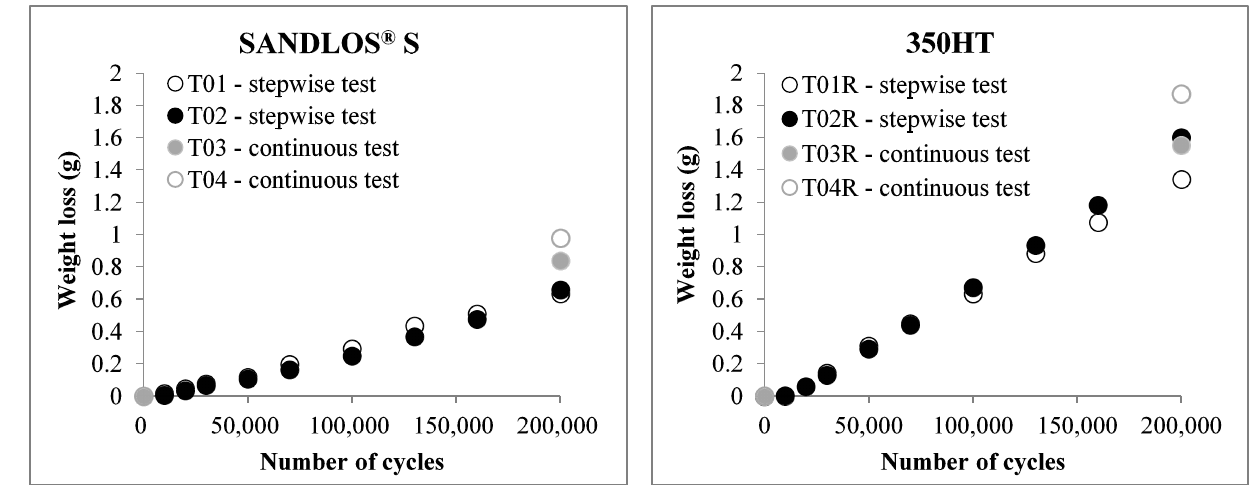
Figure 8. Weight loss of the wheel and rail discs in continuous and stepwise training tests.